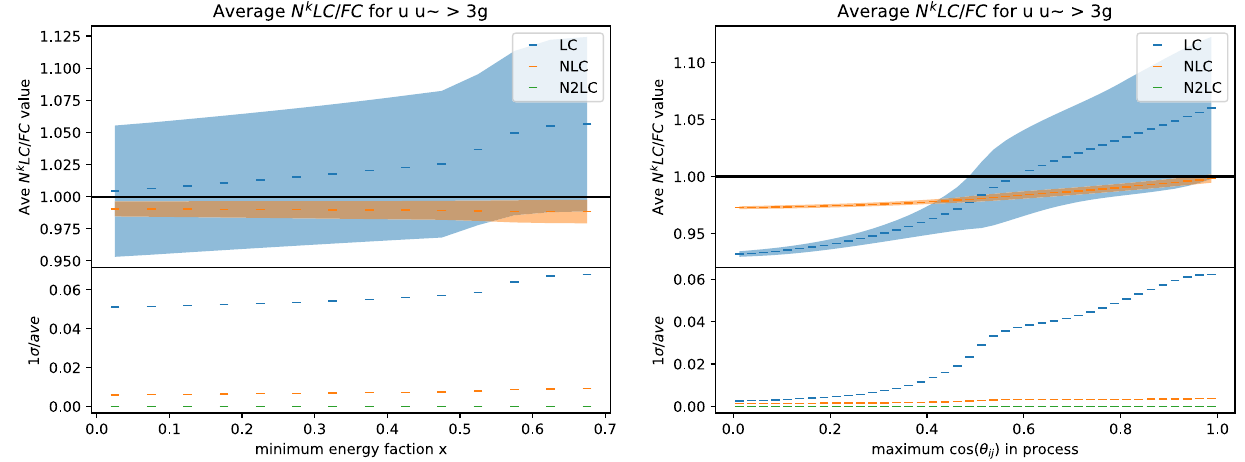
Fig. 7 Accuracy and precision of expansion in colours 1 / N c in the process u ¯ u → 3 g as a function of the minimum energy fraction x = min ( 2 E i / E cm ) of a given particle (left) and maximum cos (θ ij ) between two particles (right)